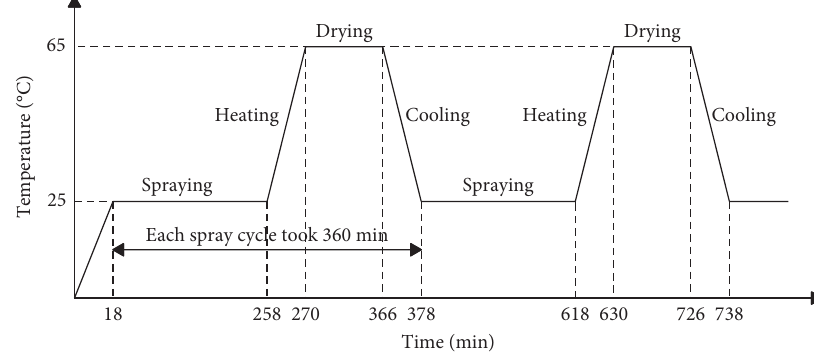
Figure 3: Corrosion scheme in the environmental